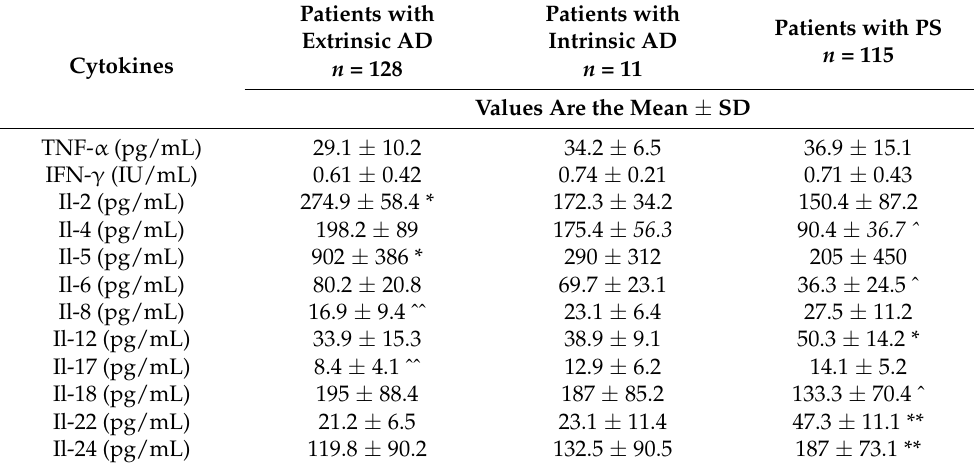
Patients with Patients with Patients with PS Extrinsic AD Intrinsic AD n = 115 n = 128 n = 11 Values Are the Mean ± SD